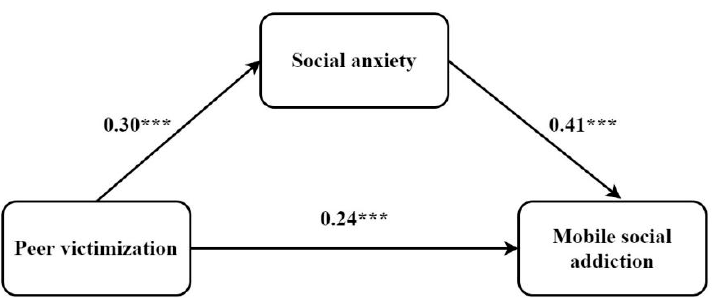
Figure 1. The mediation model of social anxiety between peer victimization and adolescent mobile social addiction. *** p < 0.001.